Question: Does the plotted quantity increase or decrease?
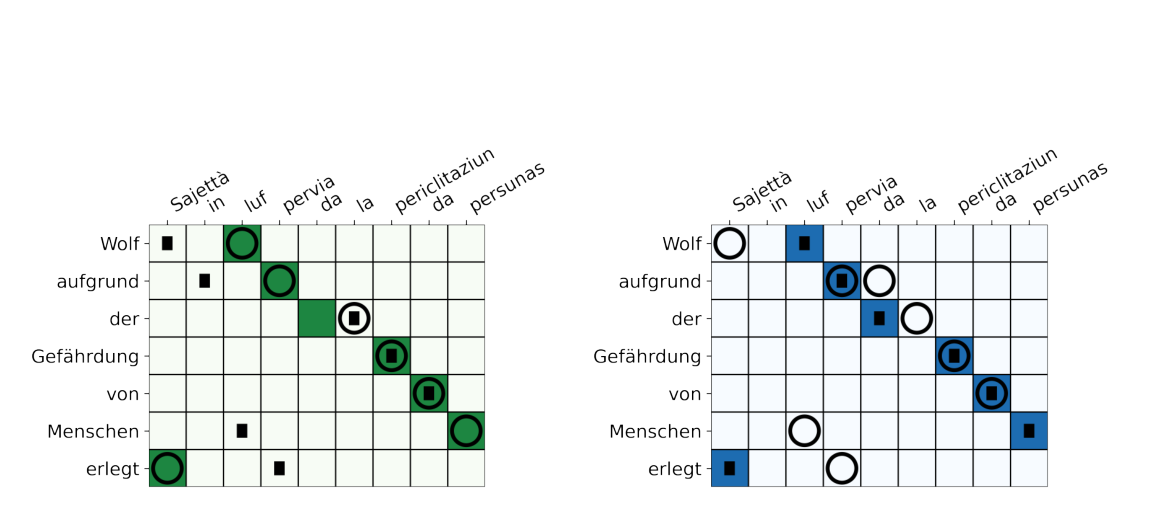
Answer: increasing